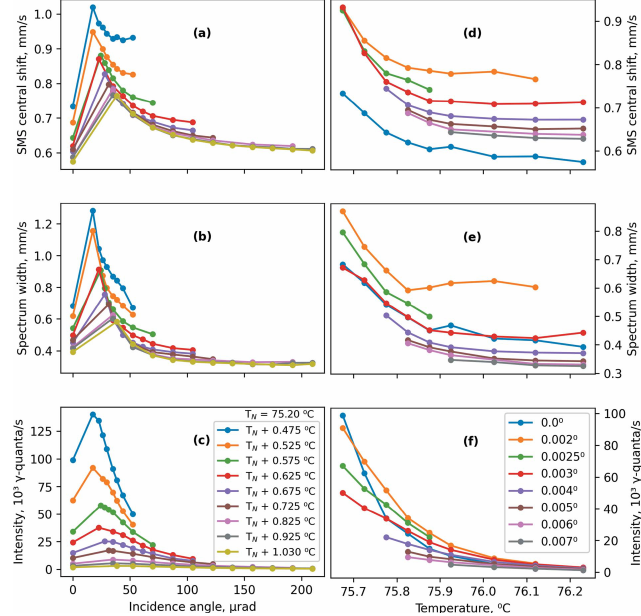
Figure 4 Summary of the derived SMS parameters. The SMS central shift ( a , d ), spectrum width ( b , e ), and intensity ( c , f ) are shown for various temperatures as a function of incidence angle ( a – c ) and for various angles as a function of temperature ( d – f